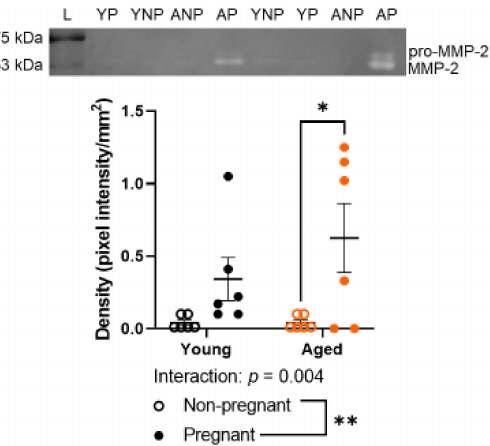
Figure 5. Densitometry analysis of activity by MMP-2 from main uterine arteries of young (black) and aged (orange) nonpregnant (open circles) and pregnant (GD 20; closed circles) rats. Representative zymography gel: the first lane has a protein ladder. Both pro-MMP-2 (72 kDa) and active MMP-2 (62 kDa) are visible. However, only MMP-2 bands had a sufficiently detectable band able to be used for analysis. Densitometry assessment: bands of clearing represent gelatinase activity by MMPs. L, ladder; YNP, young nonpregnant; YP, young pregnant; ANP, aged nonpregnant; AP, aged pregnant. Data presented as mean ± SEM; n = 6/group. Outcomes were compared using a two-way ANOVA (age vs. pregnancy status) followed by Sidak’s post hoc test. * p < 0.05; ** p <